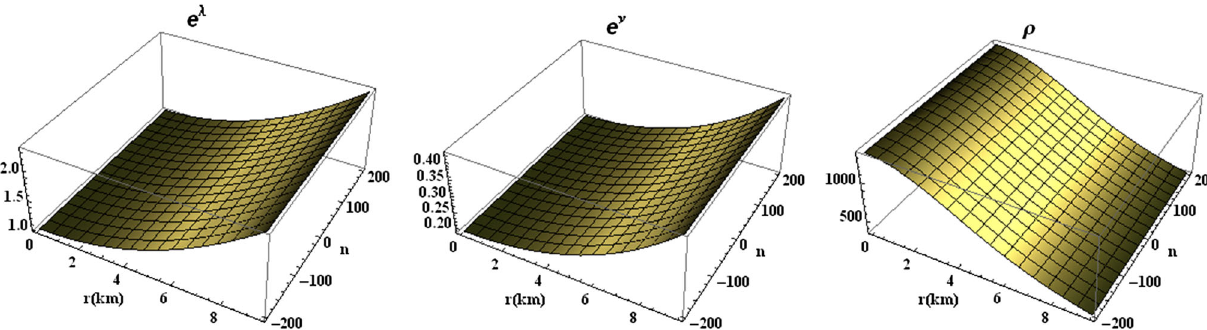
dimensionless quantity. (Right) Along x -axis, y -axis and z -axis we have respectively plotted the radius of the star in km unit, the dimensionless quantity n which lies in the range − 200 ≤ n ≤ 200 and the matter density ρ in MeVfm − 3 unit. All the profiles are drawn for a compact star of mass M = 1 . 85 M (cid:3) and radius of the star = 9 . 5 km. by fixing